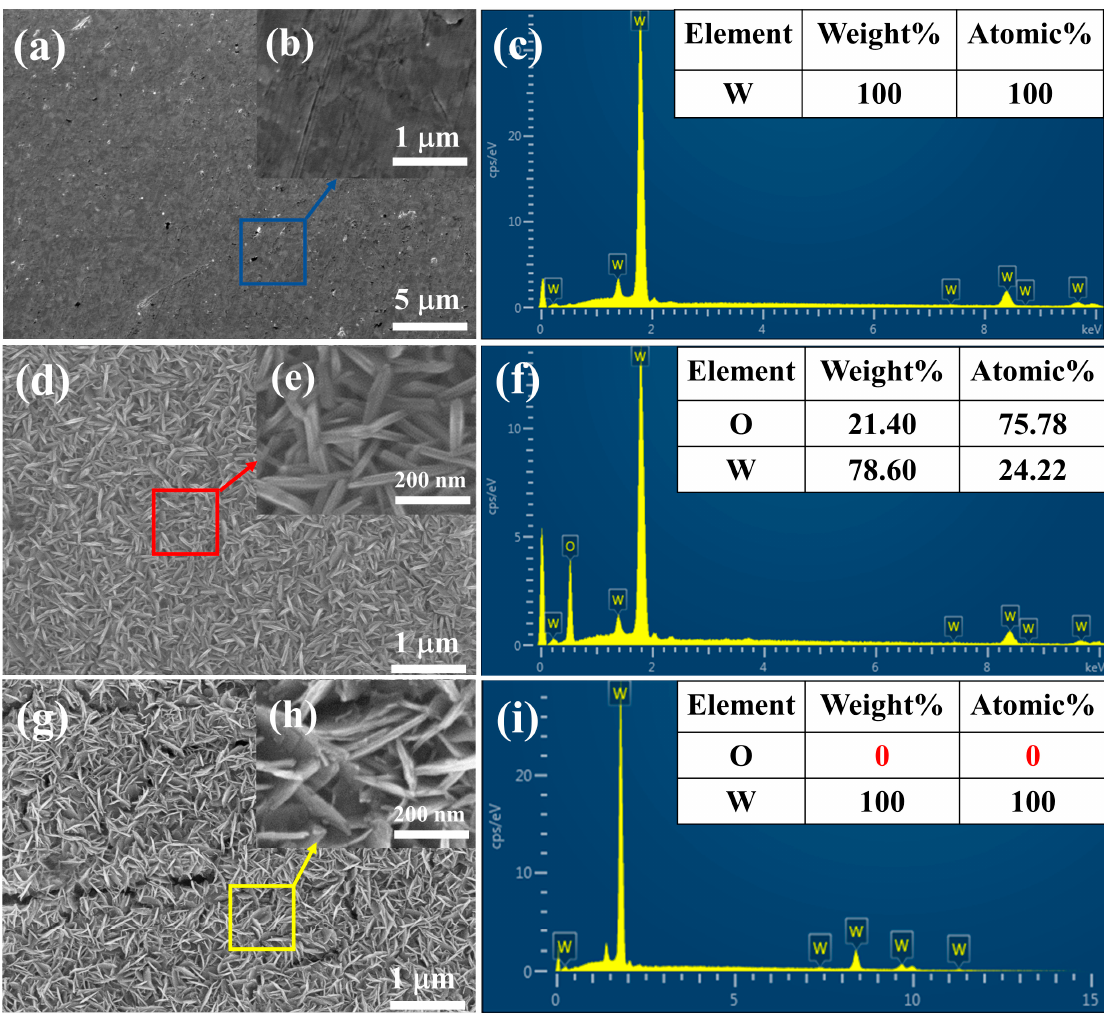
Figure 2. SEM images of the surface morphology and the corresponding EDS results of W surface: ( a – c ) before hydrothermal treatment, ( d – f ) after hydrothermal treatment, and ( g – i ) after hydrothermal treatment and reduction annealing process.